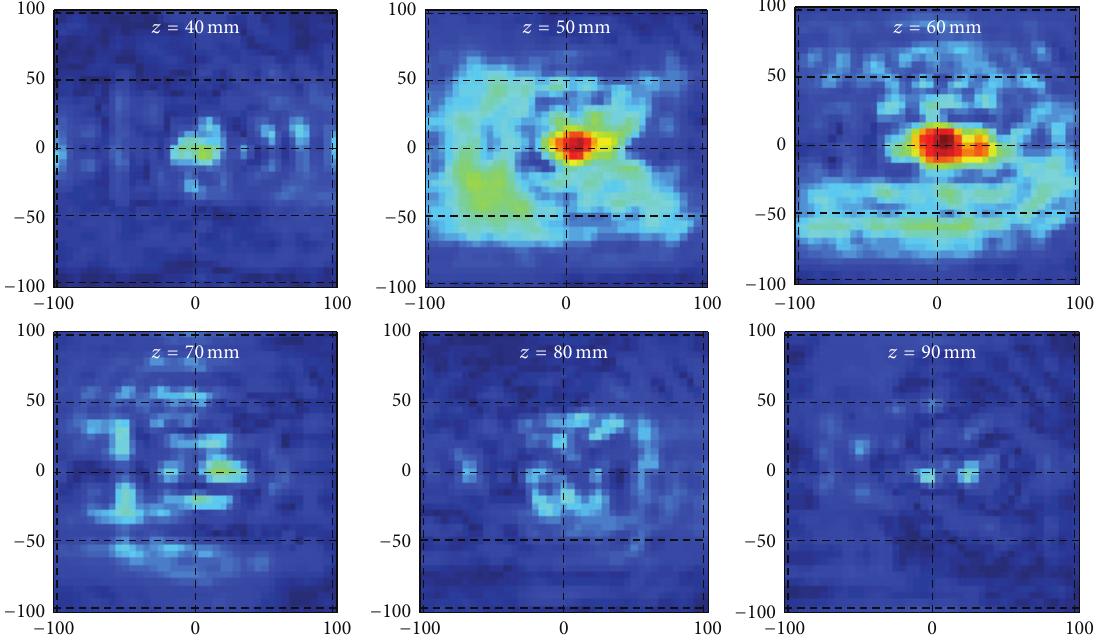
Figure 15: Reconstructed images (shown every 10mm along 𝑧 ) when the distance between the reconstruction planes is Δ𝑧 = 5mm using the data in the frequency range from 8.5 GHz to 20 GHz in the experimental example. Color bars are the same as those in Figure 5. The horizontal and vertical axes show the positions along the 𝑥 and 𝑦 directions in terms of